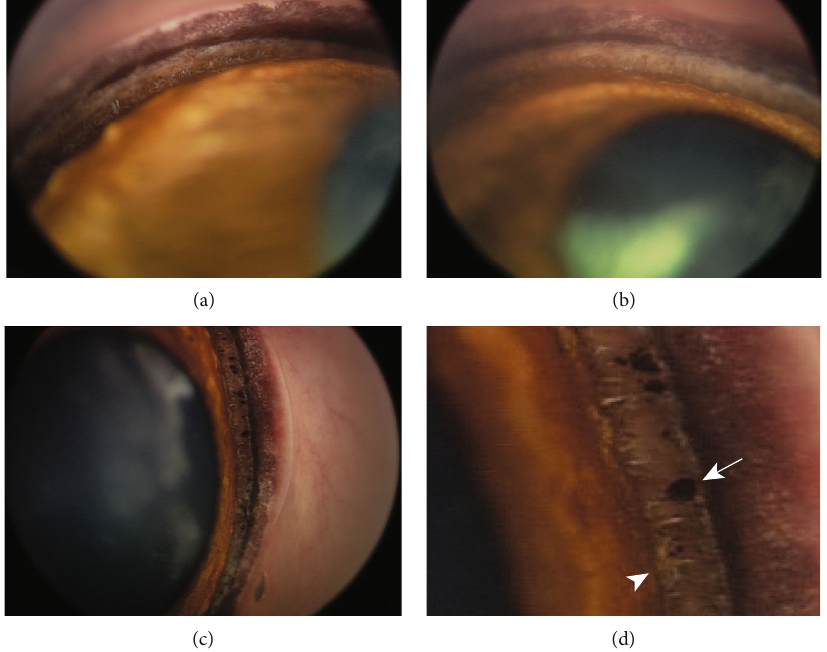
Figure 1: Gonioscopy images of both eyes with an ICA Grade 2-3 and sparse areas of fi brae latae. (a) View of one quadrant OS. (b) View of one quadrant OD. (c) View of a di ff erent quadrant OD. (d) Magni fi ed view of a sector of the ICA OD showing foci of pigment (white arrow) within the trabecular meshwork and small foci of fi brae latae (white arrowhead) at the opening of the